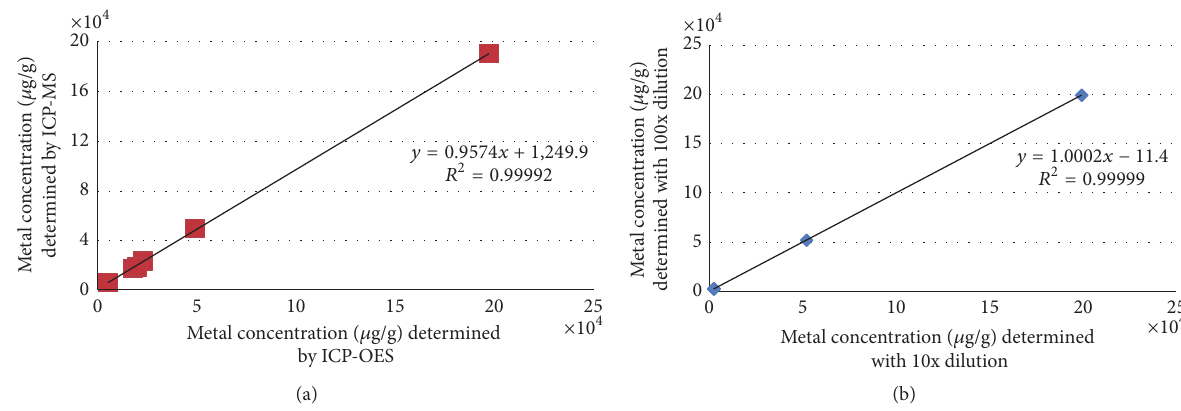
Figure 2: (a) Plot of metal concentrations in all three CNTs (NIST 2483, Test, and Aldrich) measured by ICP-MS and ICP-OES after microwave digestion (MD). (b) Plot of metal concentrations in spiked Aldrich-CNT 10 and 100 times diluted MD digests measured by ICP-MS. The straight line represents the best fit linear regression from (a) seven and (b) four pairs of concentration values (mean of five independent